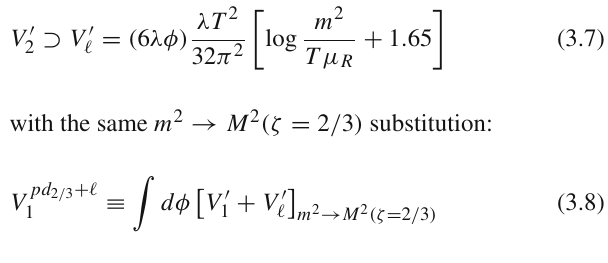
Fig. 2 Complete set of 1- and 2- loop contributions to the scalar mass, as well as the most important higher loop contributions, in φ 4 the- ory. The scaling of each diagram in the high-temperature approxima- tion is indicated, omitting symmetry- and loop-factors. Diagrams to the right of the vertical double-lines only contribute away from the origin